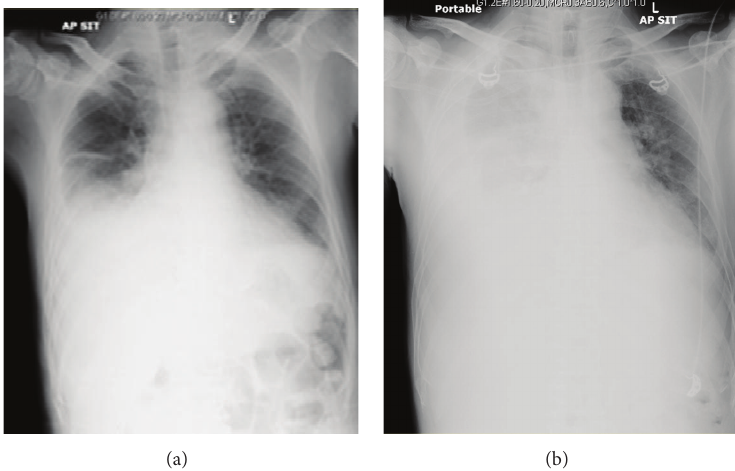
Figure 2: Chest radiographs showing a right pleural effusion on admission (a) with worsening of the effusion one day after